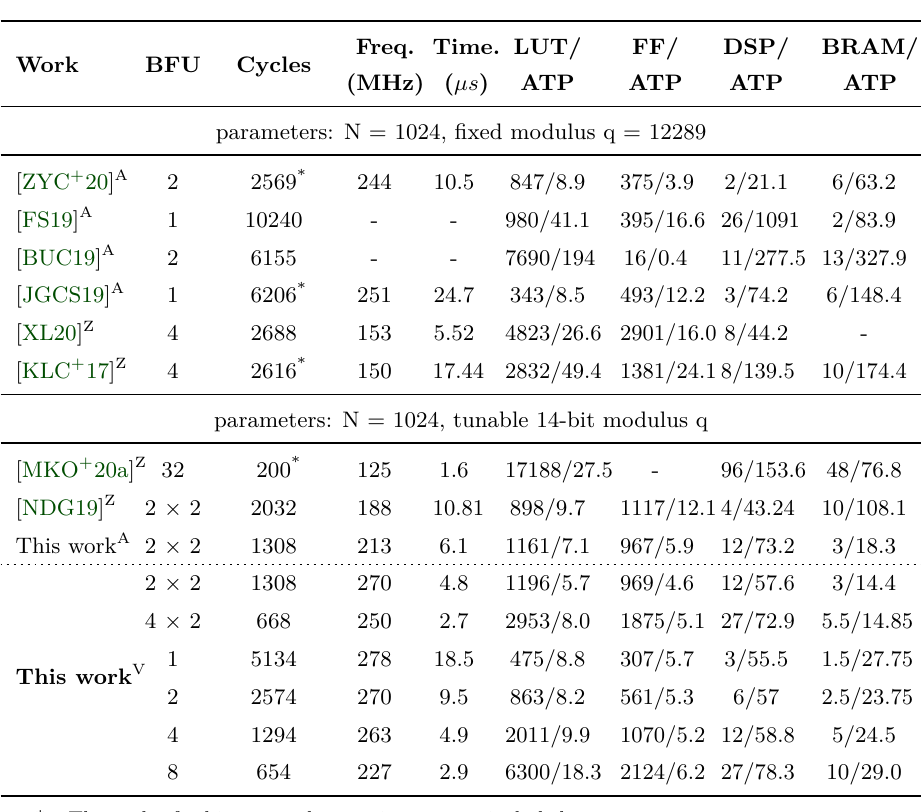
Table 3: The comparison of NTT with related